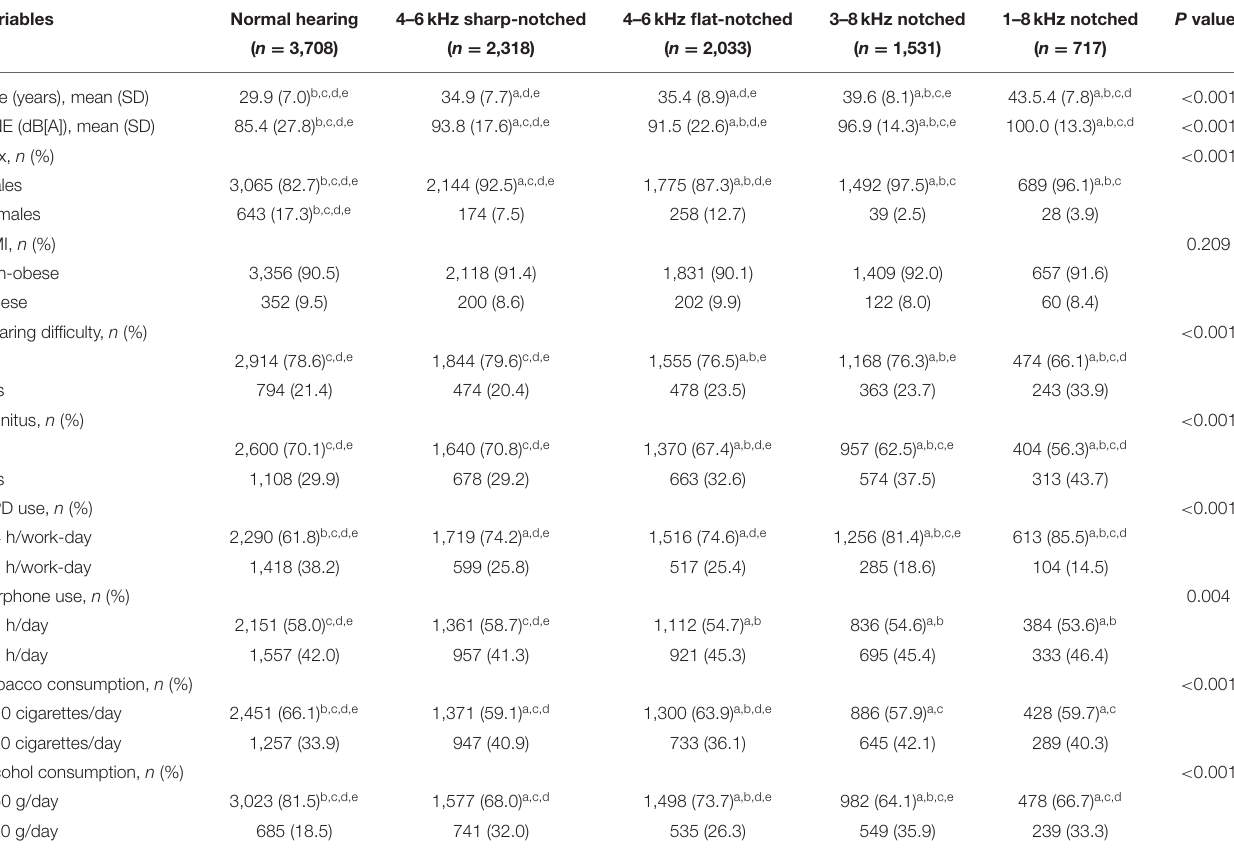
TABLE 3 | Characteristics of subjects in different audiometric phenotypes.